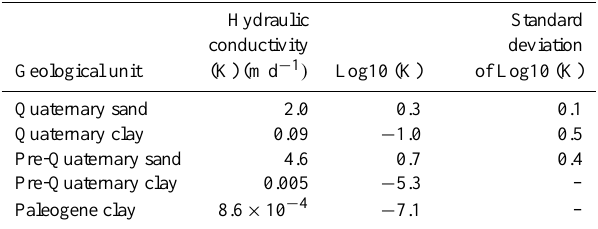
Table 2. Hydraulic conductivity of the geological units. Values for Quaternary sand, Quaternary clay and pre-Quaternary sand are found as the medians of 90 estimated parameter values from PEST and used in GeoModel-I. Values for pre-Quaternary clay and Pale- ogene clay are inferred from the